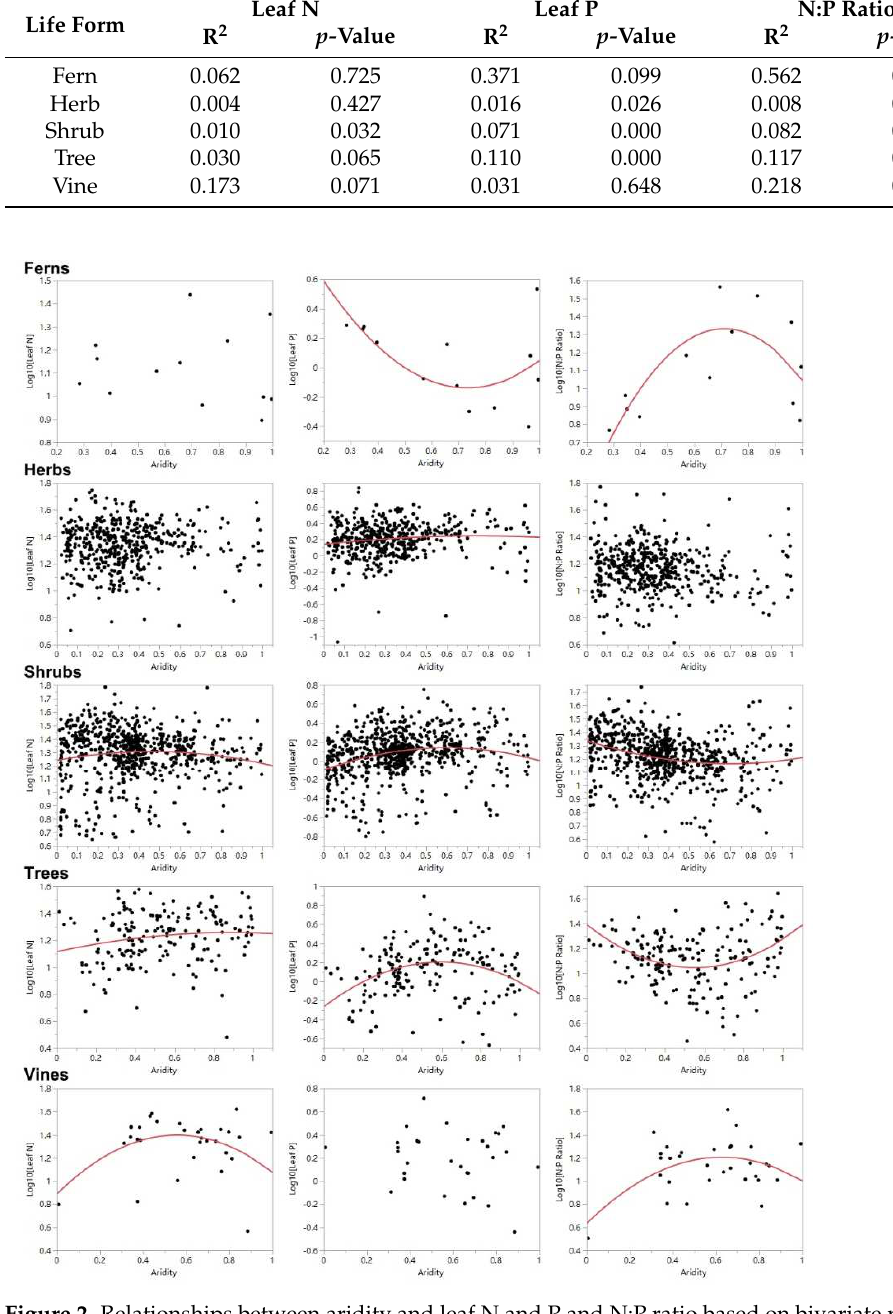
Figure 2. Relationships between aridity and leaf N and P and N:P ratio based on bivariate regression models. Aridity index values increase for more humid conditions and decrease with more arid conditions. We used log10 transformation for leaf N and P and the N:P ratio in the analysis. Leaf N was positively related to aridity for shrubs, trees, and vines ( p < 0.1; Figure 1